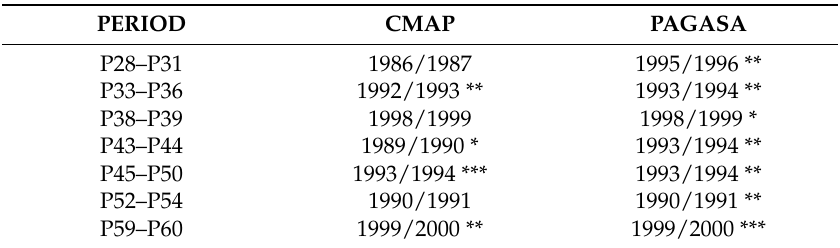
Table 1. Summary of change points based on the Pettitt test between the CMAP and PAGASA rainfall